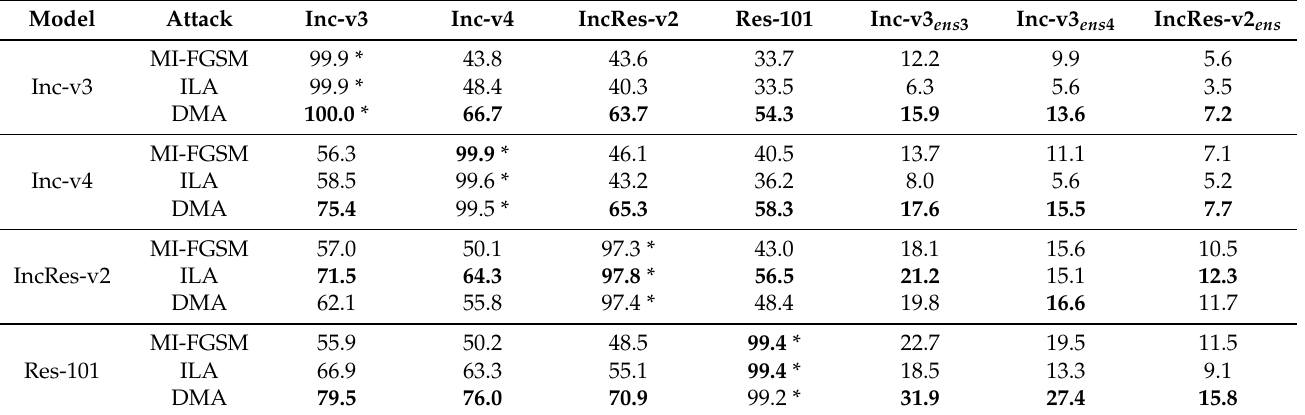
Table 1. The success rates of MI-FGSM, ILA, and DMA. The proxy of ILA is crafted by MI-FGSM. The adversarial examples are crafted for Inc-v3, Inc-v4, IncRes-v2, and Res-101, respectively. * indicates the white-box